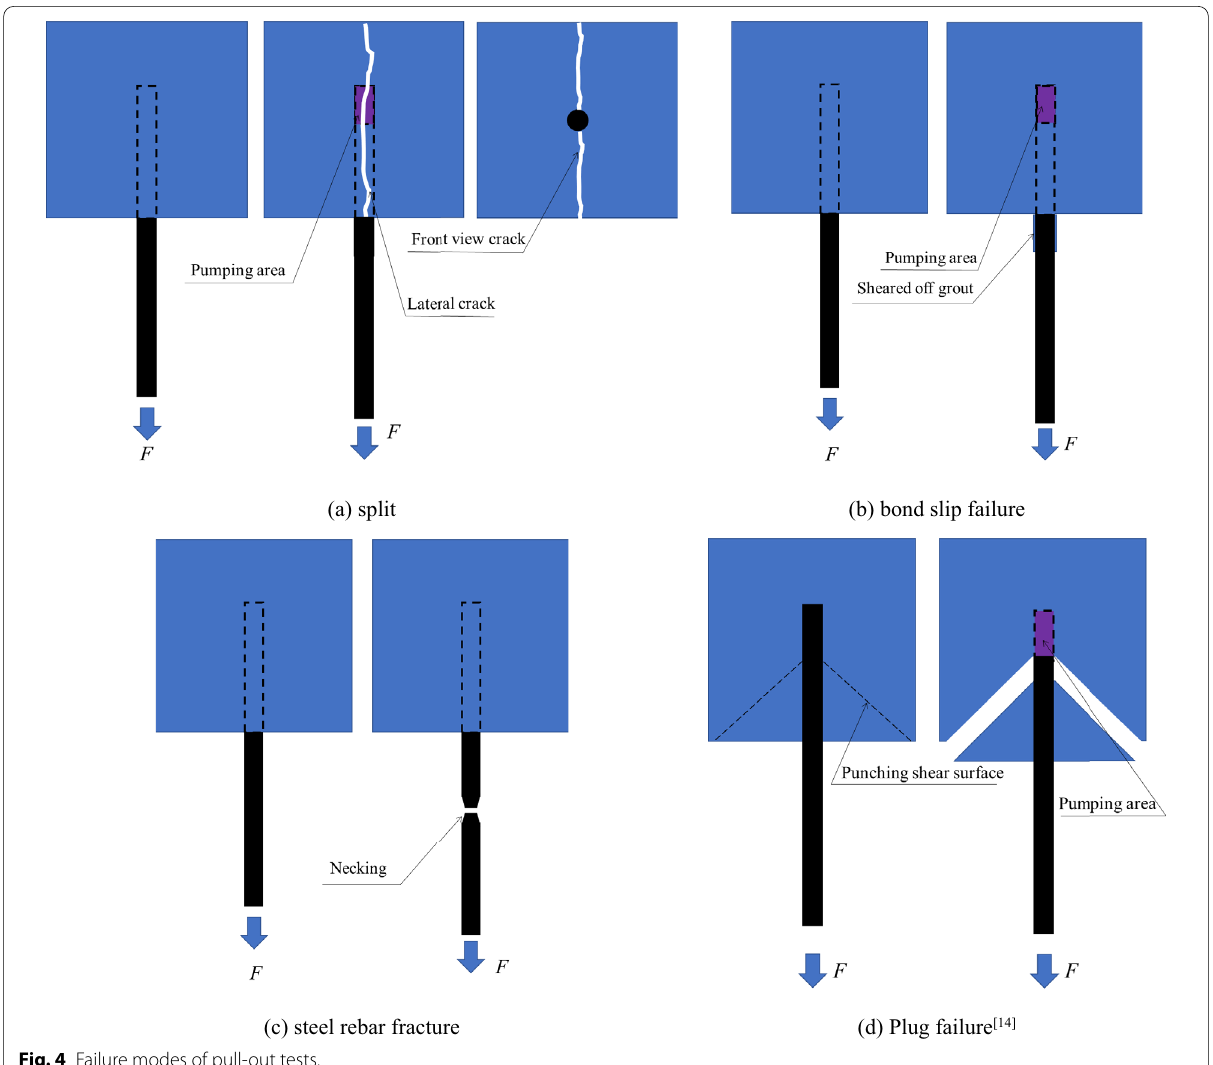
Fig. 4 Failure modes of pull‑out